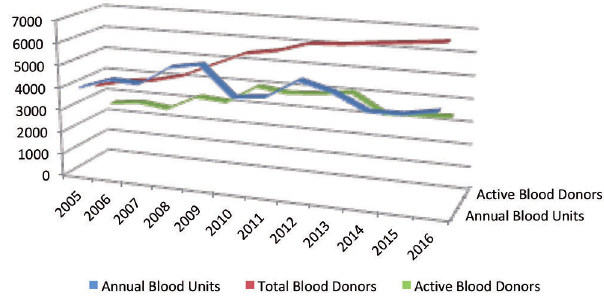
Figure 2. Total registered blood donors, active blood donors (June 2017) and Annual Blood units donated for thalassemia patients during the last twelve years